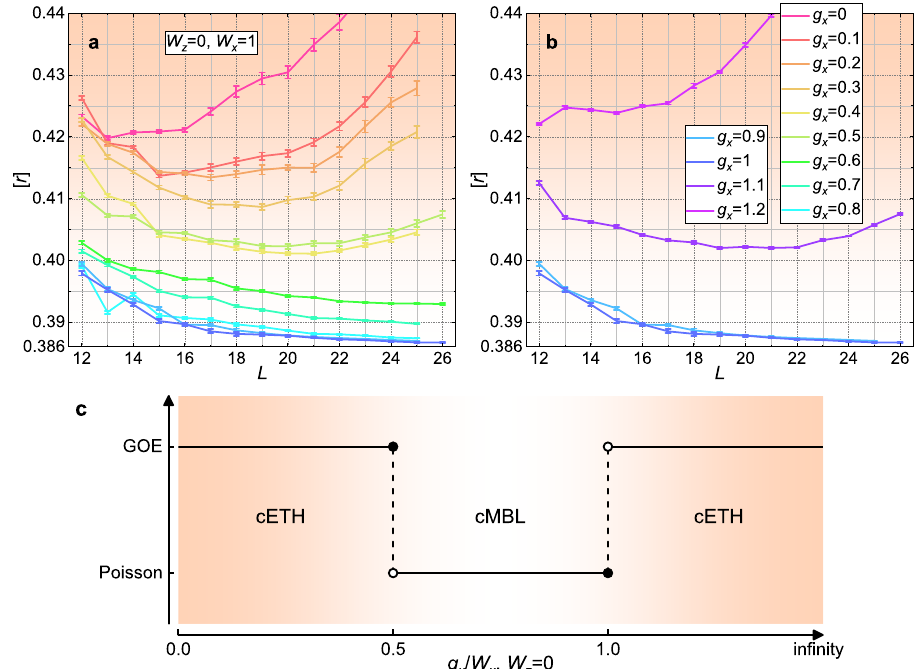
Fig. 1 Spectral diagnostics of the cMBL-cETH transition based on the scaling analysis of [ r ] using OBCs. The maximal chain length is pushed to L = 26. Under the constrained limit W z = 0, the model ’ s [ r ]-value forms a systematic trend in approaching r Poi when g x 2 ð 0 : 5 ; 1 (cid:3) , W x demonstrating the realization of cMBL. Panels a , b show the proposed respective discontinuity for the left and right boundary of the transition. Panel c schematizes the ideal phase diagram along the (off-diagonal) constrained line in the thermodynamic limit where, as denoted by black dots, the chain at the left discontinuous transition point g x = 0.5 is thermalized, whereas it remains fully localized at the right discontinuous transition point g x = 1. This cMBL phase survives to fi nite W z (cid:4) 0 : 5 , hence forming a dome separated from both the constrained W x thermal phase at leading g x and the dMBL state at dominant W z